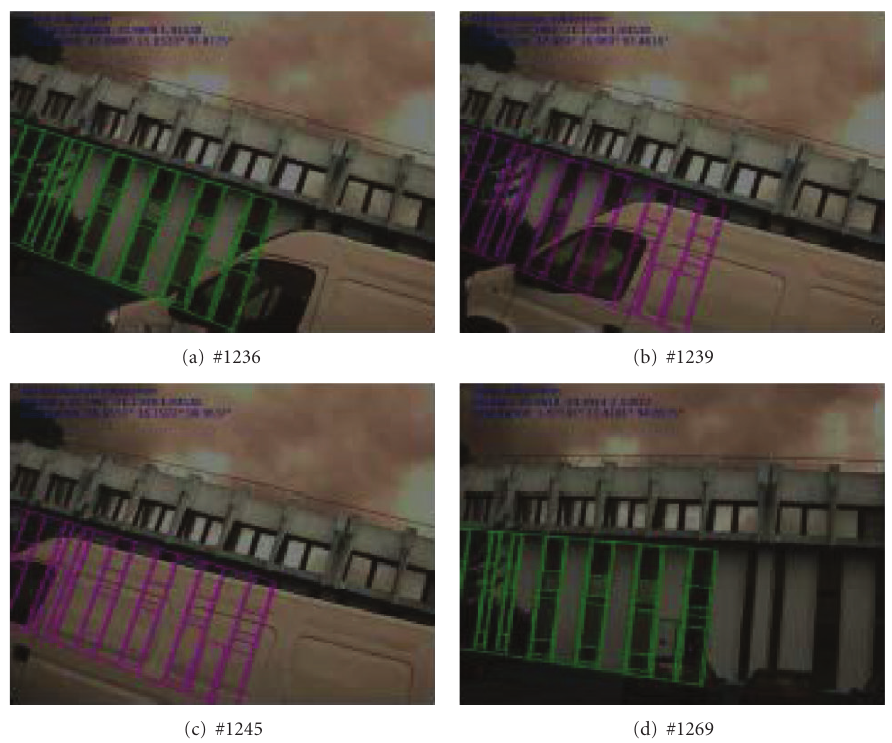
Figure 16: Registration of the 3D model using the auxiliary subsystem: Occlusion